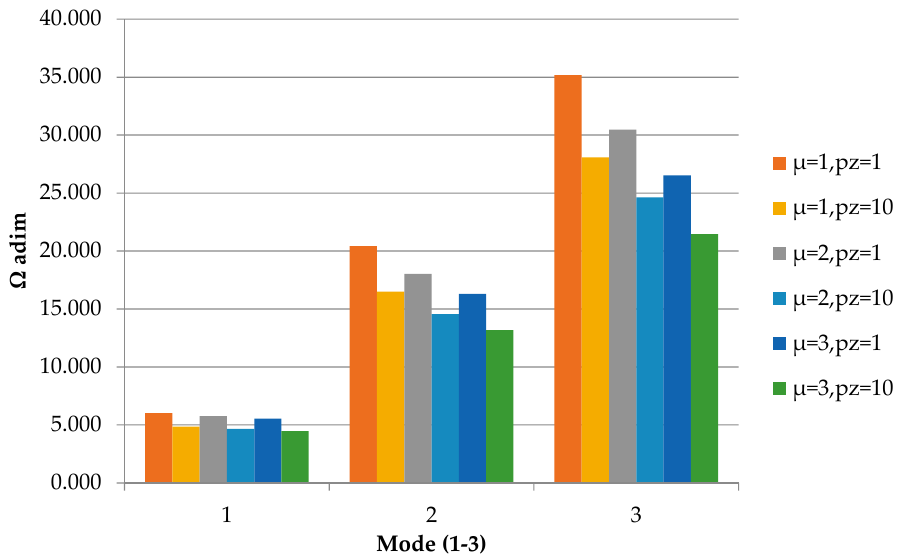
(cid:2960) (cid:3159)(cid:3162)(cid:3167)(cid:3171)(cid:3138)(cid:3139)(cid:3145)(cid:3117)(cid:3127)(cid:3156) (cid:3440) , denoting the relations between (cid:2960) (cid:3159)(cid:3162)(cid:3167)(cid:3171)(cid:3138)(cid:3139)(cid:3145)(cid:3117)(cid:3127)(cid:3158)